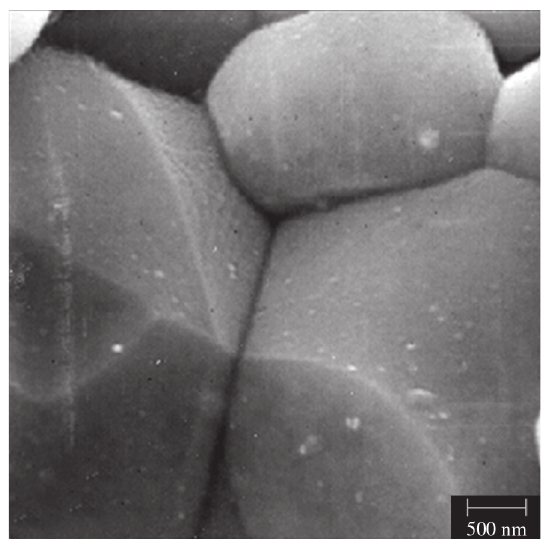
Figure 6. SEM micrograph of magnified detail of the ZPNC-2 microstructure showing that ZnO grains are in direct contact with each